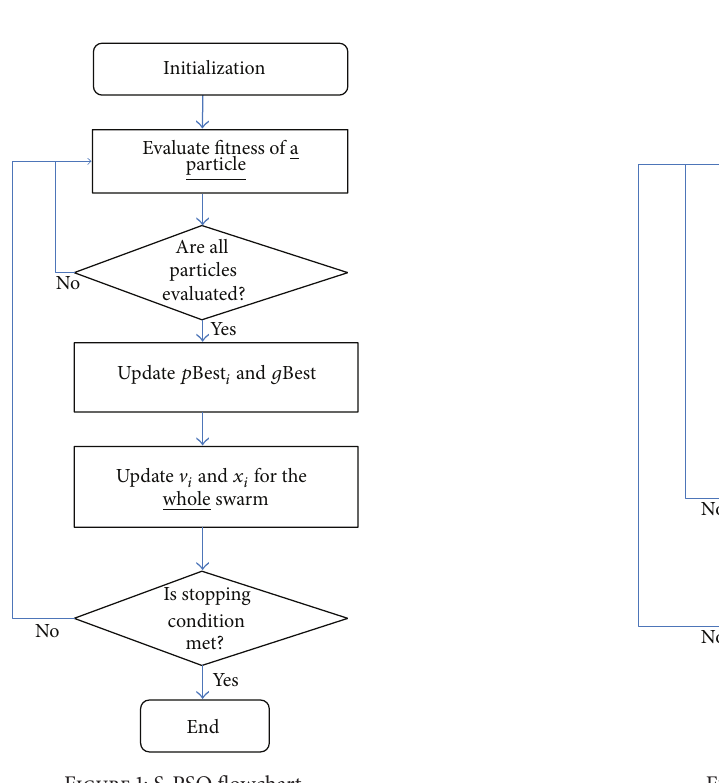
Figure 1: S-PSO flowchart. Figure 2: A-PSO